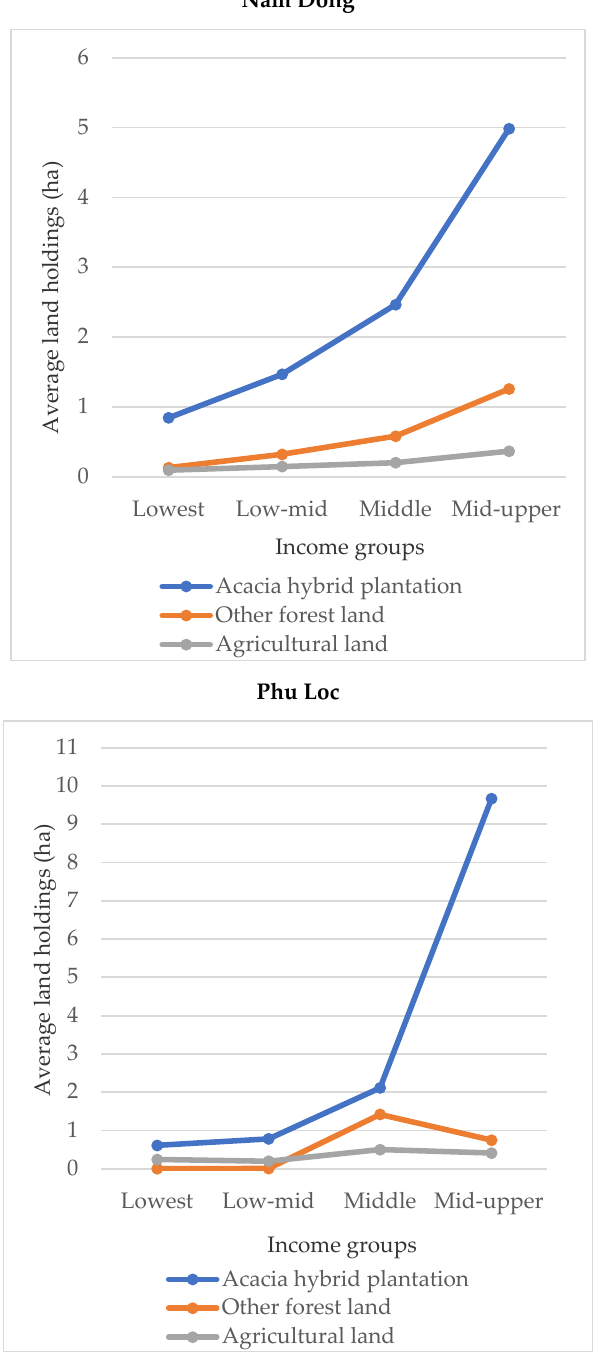
Figure 2. Distribution of main land-use types by income groups in Nam Dong and Phu Loc districts. Source: Field research (2018, 2019).